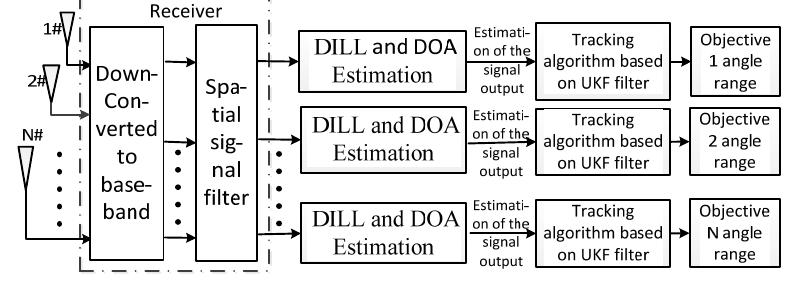
Figure 1. Locating and tracking model.